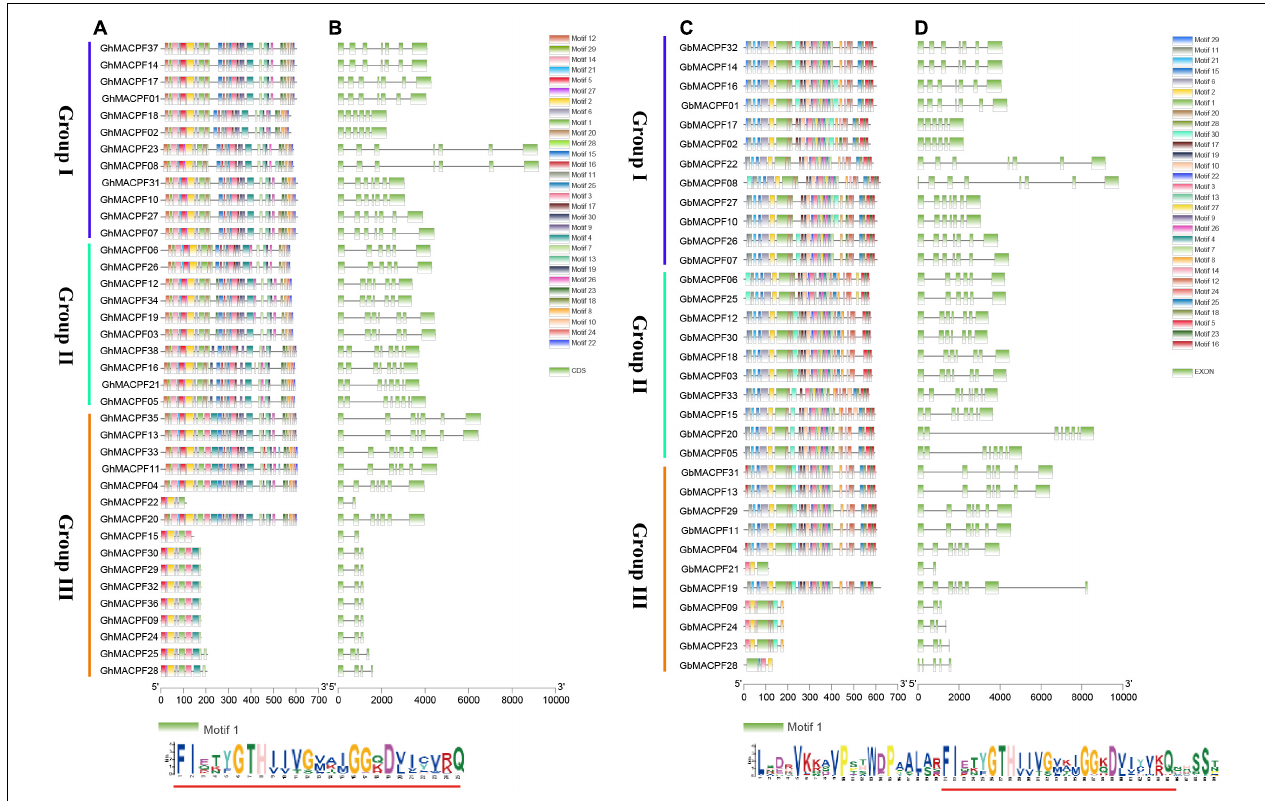
FIGURE 2 | Motif and gene structure of the MACPF member in the allotetraploid cotton. (A,C) Are the converted motif and (B,D) are the gene structure of the MACPF